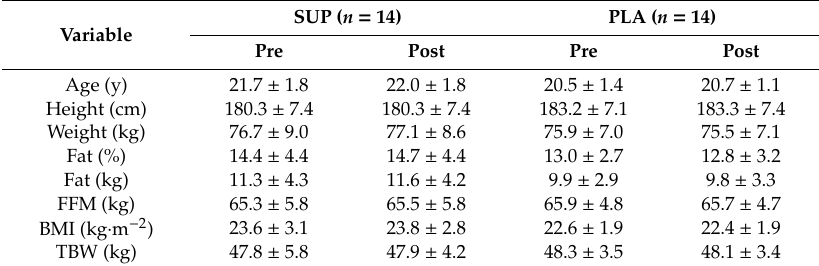
Table 1. Demographic and clinical